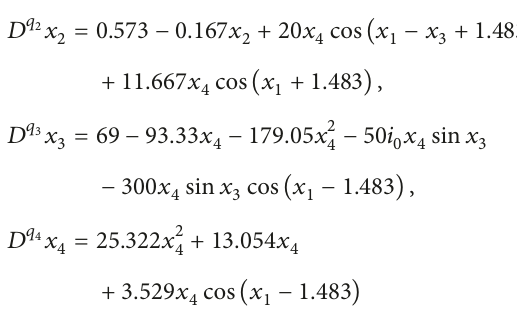
, 𝜔, 𝛿 , 𝑉 ] 𝑇 ) , 𝑖 𝑡 𝐿 𝐿 0 is